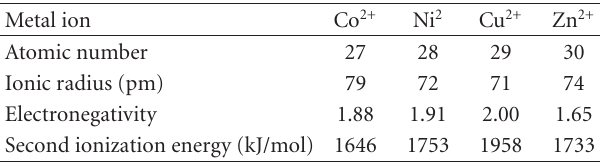
Table 3: Atomic number, ionic radius, electronegativity, and ionization potential of the investigated bivalent metal ion a .